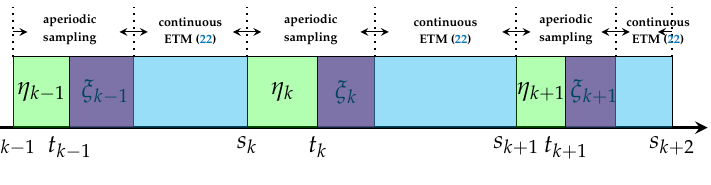
Figure 2. Timing diagram for ETM. ( a ) Switching ETM depending on communication delays. ( b ) Switching ETM depending on communication delays and aperiodic